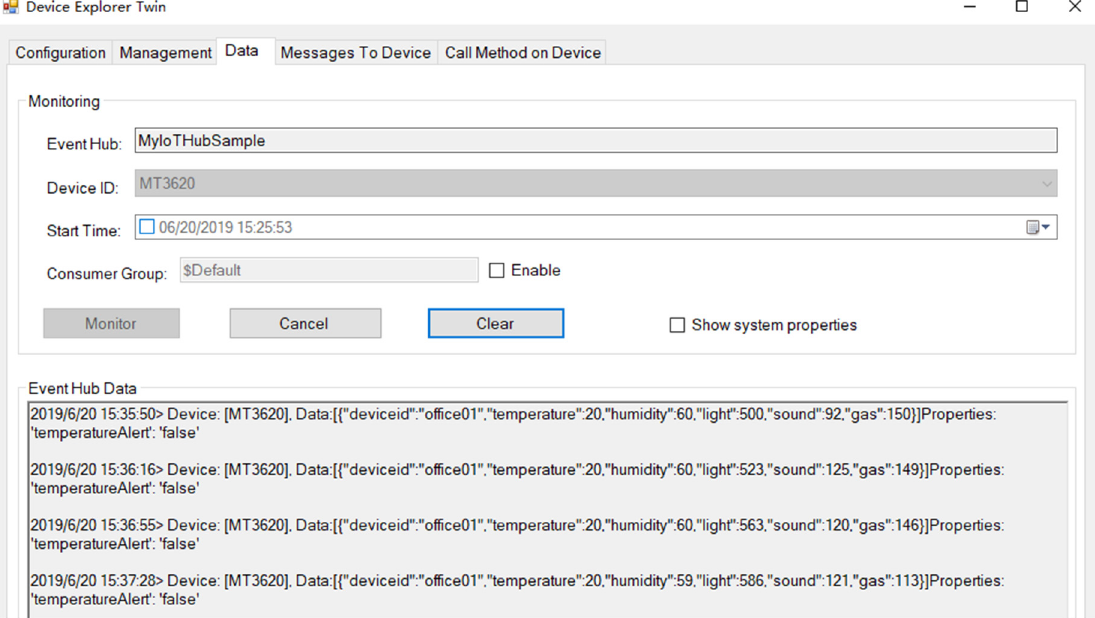
Figure 11. Azure IoT Hub Data Monitor.